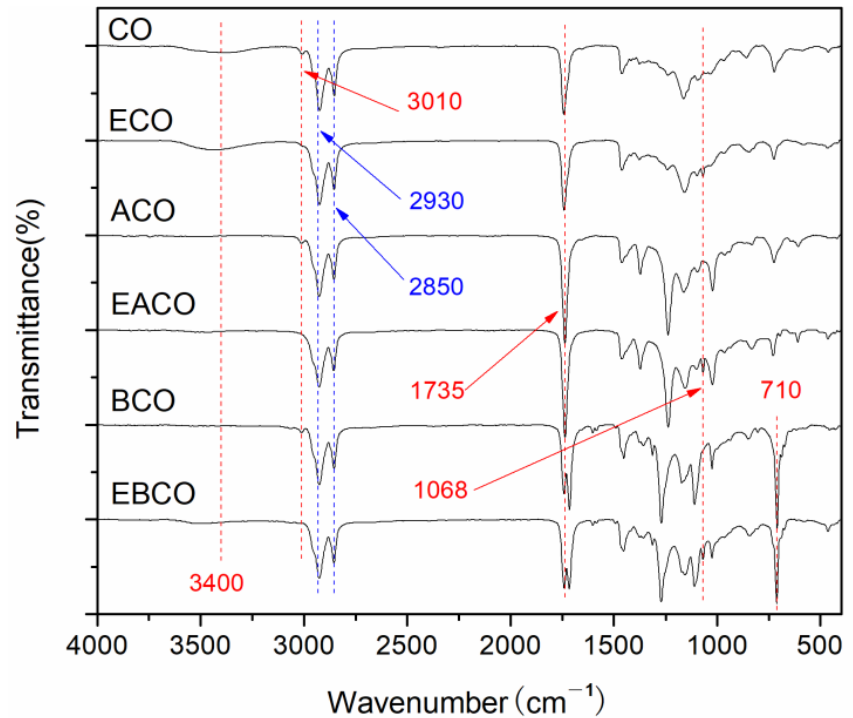
Figure 1. FT-IR spectra of CO and plasticizers synthesized.